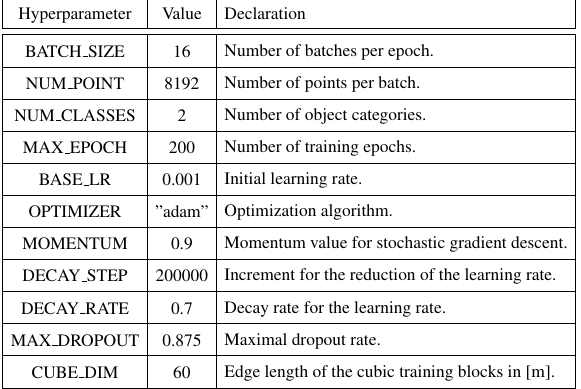
Table 1. Hyperparameters and default / optimized values